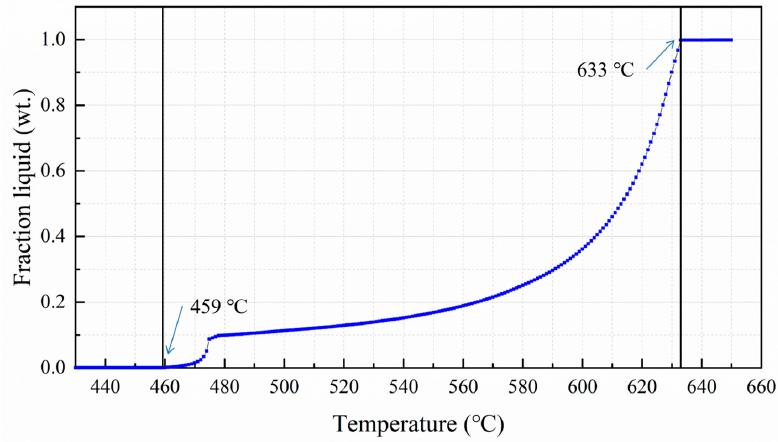
Figure 2. Liquid fraction of Al-6.54Zn-2.40Cu-2.35Mg-0.10Zr aluminum alloy with temperature calculated by JmatPro software.